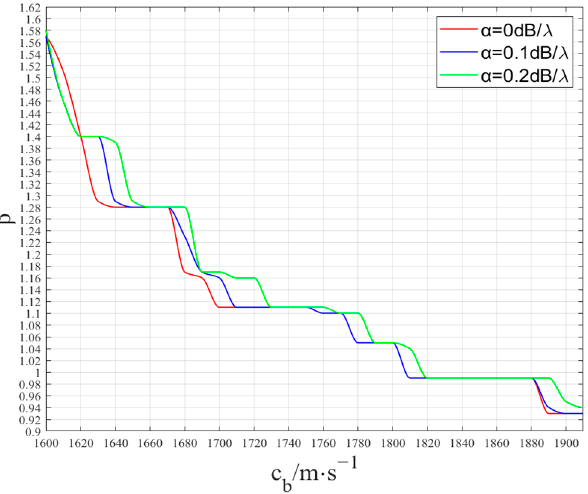
Figure 5. Variations of waveguide invariant parameter β corresponding to 200–300 Hz frequency band with bottom sound speed c b calculated for different values of bottom sound absorption α .